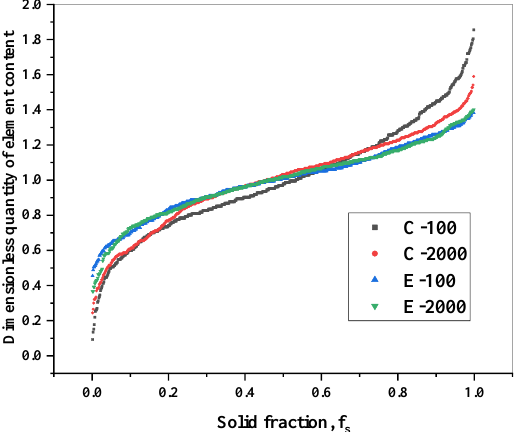
Figure 3. Typical dimensionless quantity distributions of element content with solid fraction in metal microstructure grayscale analysis (MGA). (C means the columnar grain sample. E means the equiaxed grain sample. The number is the